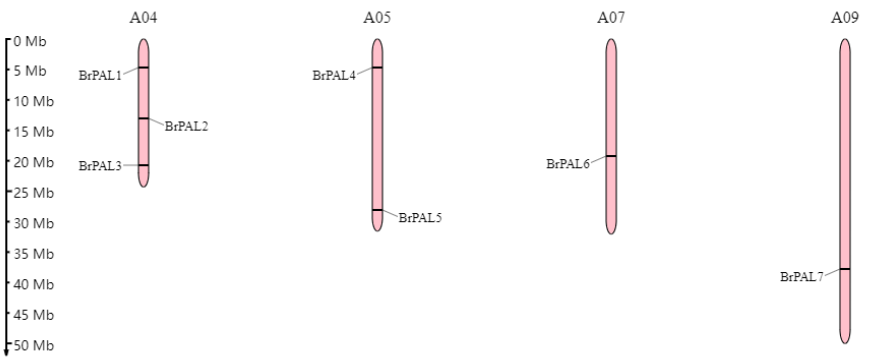
Figure 1. Chromosomal locations of seven BrPALs in the cabbage genome.